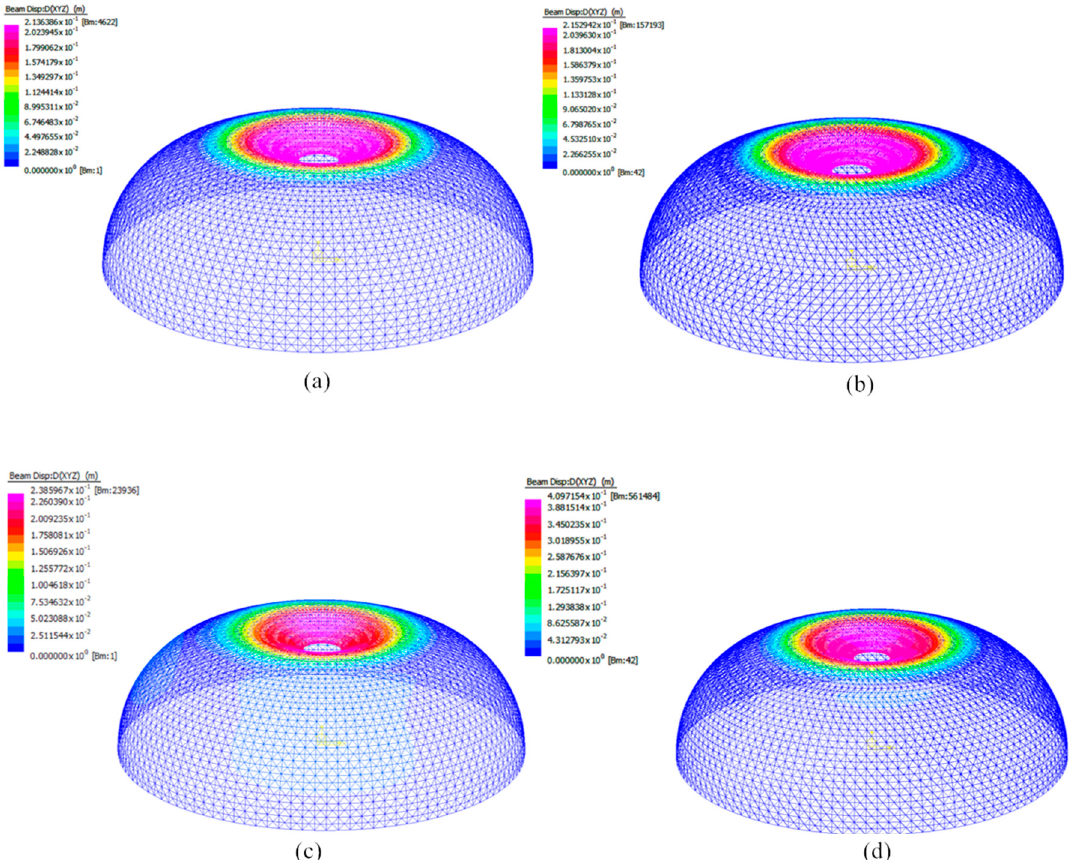
Figure 15. ( a ) Total beam displacement in the straight member model by linear static analysis (G + 0.7Q); ( b ) total beam displacement in the curved member model by linear static analysis (G + 0.7Q); ( c ) total beam displacement in the straight member model by linear static analysis (G + 0.7Q + W); ( d ) total beam displacement in the curved member model by linear static analysis (G + 0.7Q + W).